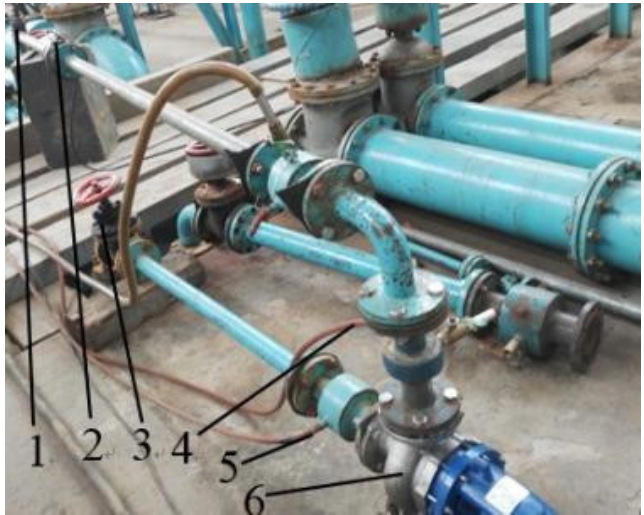
Figure 3. Experiment setup. 1. Outlet valve, 2. Electromagnetic flowmeter, 3. Inlet valve, 4. Outlet pressure transducer, 5. Inlet pressure transducer, 6. Test pump.